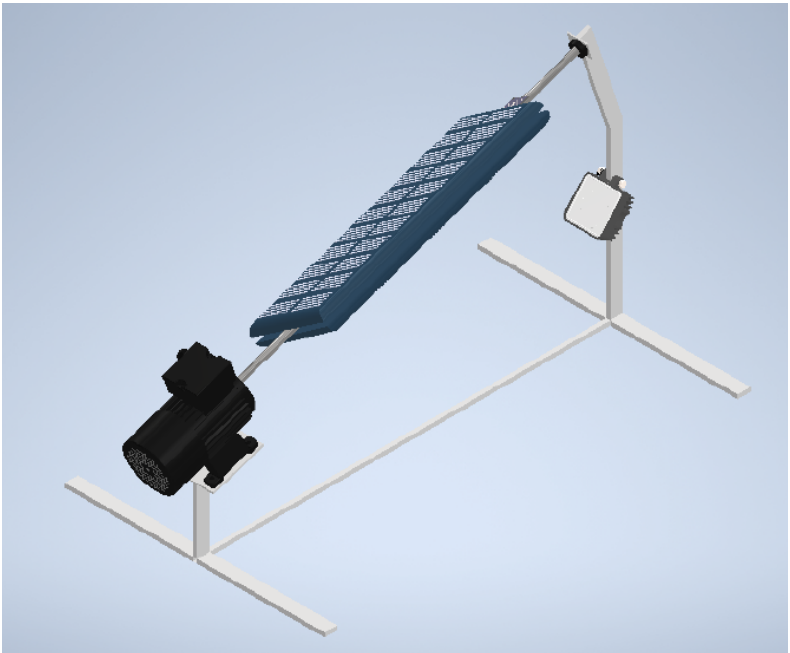
Figure 14. 3D model of the duplicated uni-axial solar cell. U1 and U2 are the two digitized sensor outputs, the solar panel will turn in the direction of the smaller measured value until it reaches the predefined lower error limit resulting from the difference between U1 and U2. In cloudy weather conditions, a